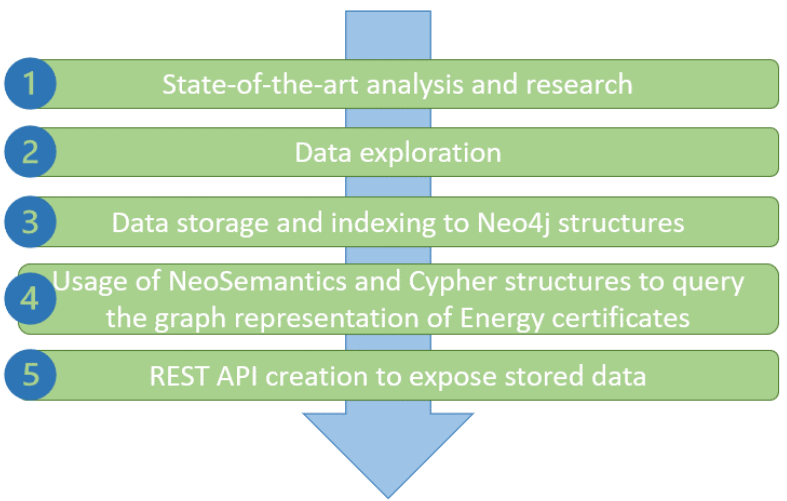
Figure 1. Methodology of the proposed Reasoning Engine architecture .